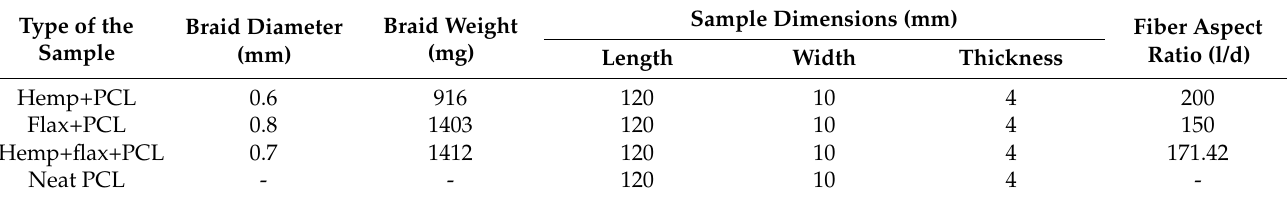
Table 2. Types of samples produced for tensile testing.